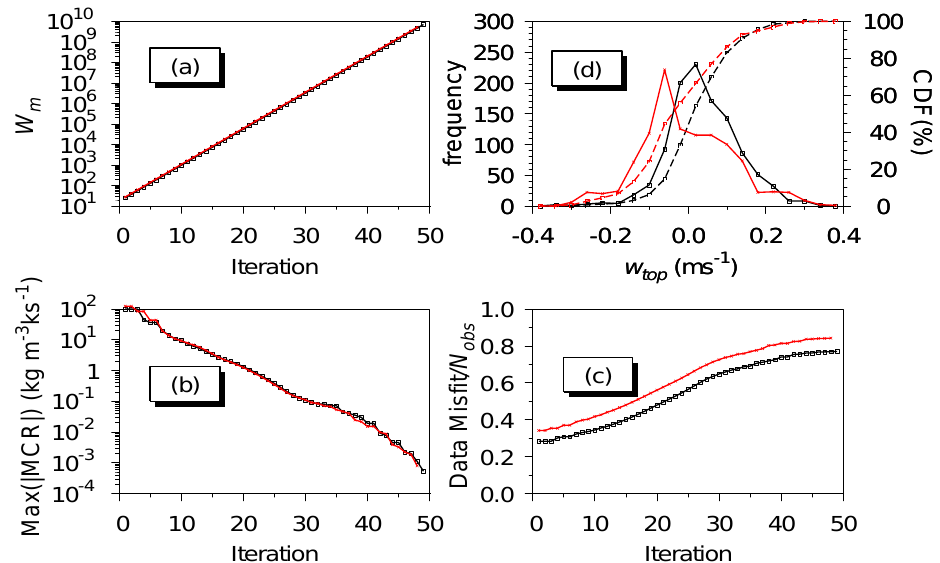
Fig. 7. In this figure, an iteration represent a cycle through the steps 4 to 6 of the variational algorithm (Sect. 2.3). The black color shows the results for the synthesis using only radar data, while the red color is used for the synthesis using radar plus sounding data. Panel (a) shows the increase of the penalty parameter associated with the anelastic mass continuity term, W m , as a function of the iteration; panel (b) shows the absolute value of the maximum residual of the mass continuity equation at any point on the grid; panel (c) shows the data misfit, scaled by the total number of observations, as a function of iteration. Finally panel (d) shows histograms and the associated cumulative distribution functions of the vertical velocity at the top of the domain. These velocities are obtained via vertical integration of the detrained mass flux of the accepted solution (last iteration) and therefore offer an estimate of the accumulation of error due to the residual in the mass continuity